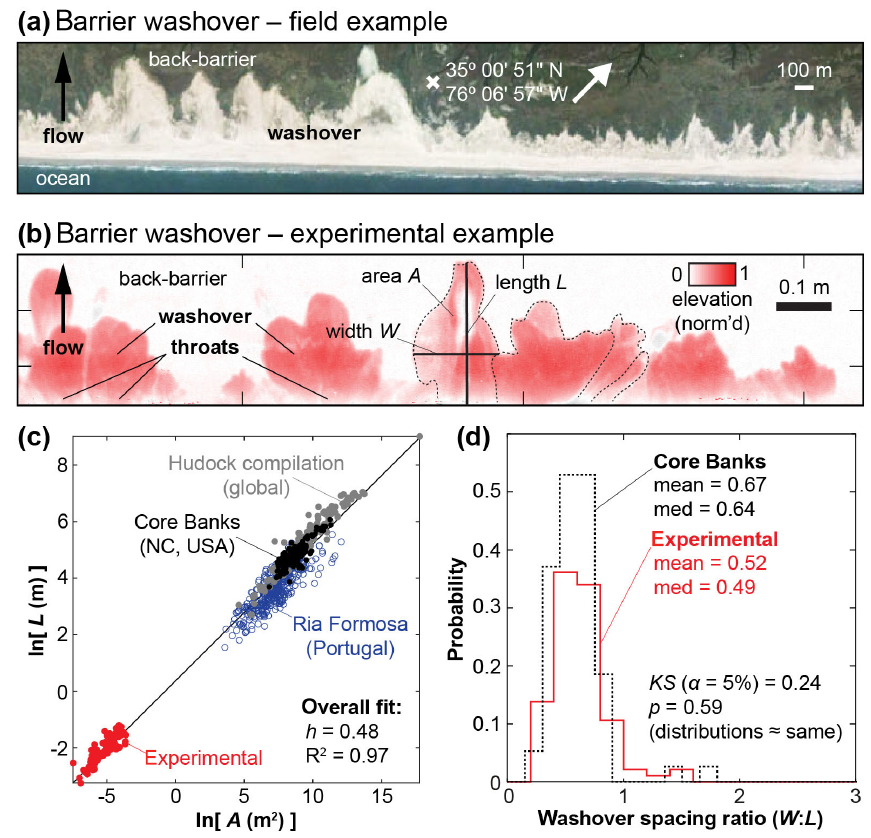
Figure 1. This study is motivated by previous work by Lazarus (2016), from which these four panels are adapted, on morphometric re- lationships in experimental and real coastal overwash morphology. (a) Example of coastal barrier washover morphology on Core Banks (North Carolina, USA; image from 2015, via Google Earth). (b) Details from a topographic laser scan (normalized relative to maximum elevation) of experimental washover morphology, annotated with key morphometric attributes (cross-shore length L , alongshore width W , and area A ). (c) Log transform relating length and area in experimental (red) and real washover deposits, including measurements from Core Banks (black dots; Lazarus, 2016), a global sample of washover deposits (grey dots; Hudock, 2013; Hudock et al., 2014), and Ria Formosa, Portugal (blue circles; Matias et al., 2008), examined in this study. Collectively, the datasets demonstrate a power relationship with a scaling exponent h = 0 . 48. (d) Stair plot from Lazarus (2016) comparing the alongshore spacing ratios ( W : L ) of real (Core Banks) and experimental